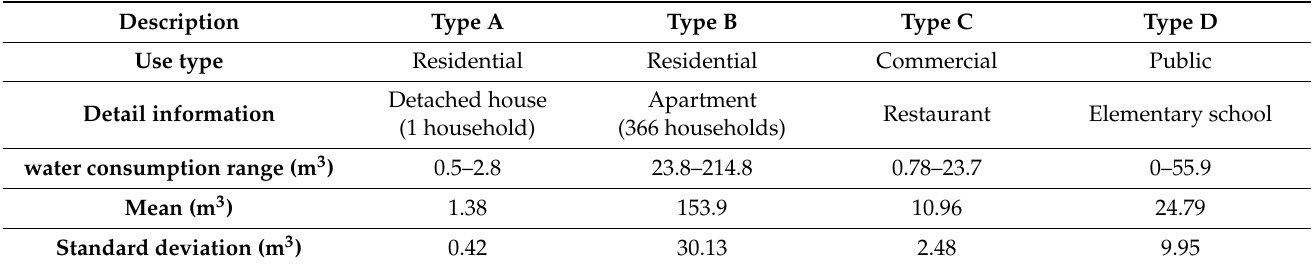
Table 1. Water consumption data for each water-use type.